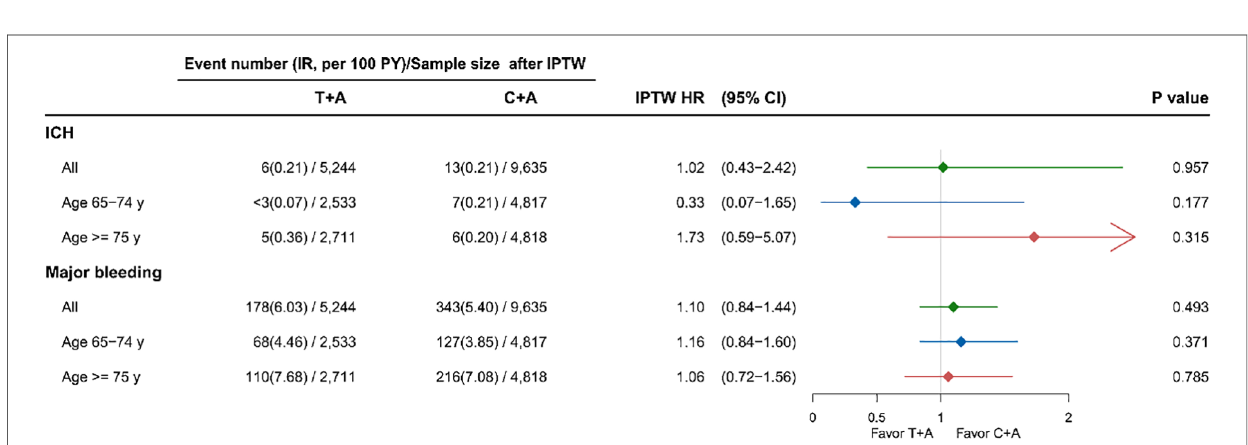
FIGURE 3 Safety of ticagrelor and clopidogrel on ICH and major bleeding among AMI patients. A, aspirin; AMI, acute myocardial infraction; C, clopidogrel; HR, hazard ratio; ICH, intracerebral hemorrhage; IPTW, inverse probability treatment weighting; T, ticagrelor; y, years.